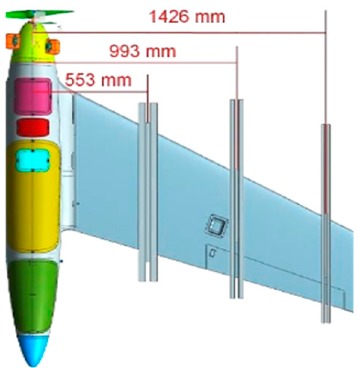
Figure 6. Position of the wing clamps.